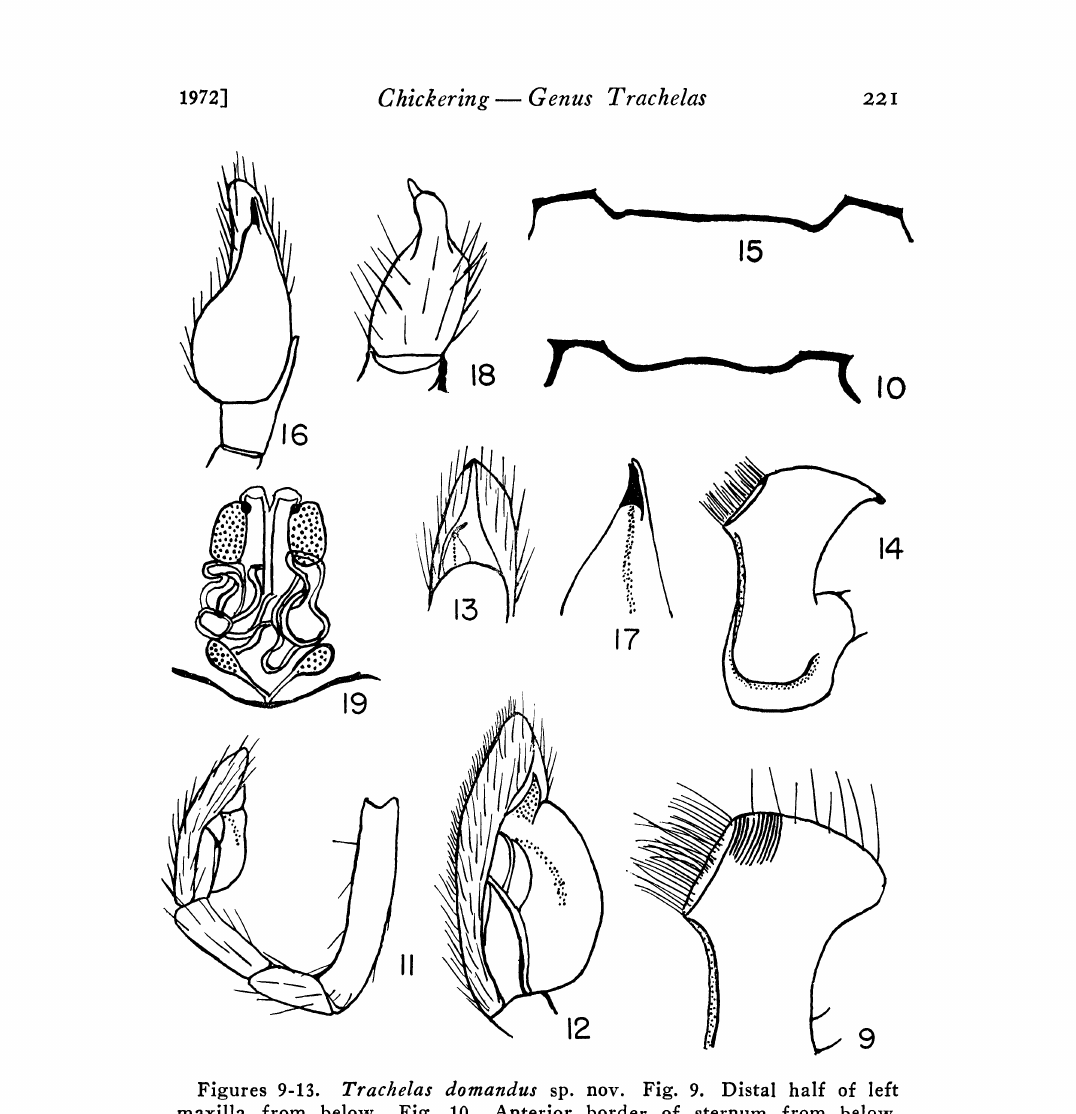
Figures 9-13. Trachelas domandus sp. nov. Fig. 9. Distal half of left maxilla from below. Fig. 10. Anterior border of sternum from below. Fig. 11. Left palp of holotype; prolateral view. Fig. 12. Left palpal tarsus; prolateral view; more enlarged. Fig. 13. Distal end of left palpal tarsus; ventral view. Figs. 14-19. Trachelas ecudobus sp. nov. Fig. 14. Left maxilla of a paratype male; from below. Fig. 15. Anterior border of sternum of holotype from below. Fig. 16. Left palpal tibia and tarsus of holotype; nearly ventral view. Fig. 17. Distal end of left palpal tarsal bulb removed from cymbium of a paratype male. Fig. 18. Left palpal tibia of holotype to show apophysis. Fig. 19. Epigynum of described female paratype from